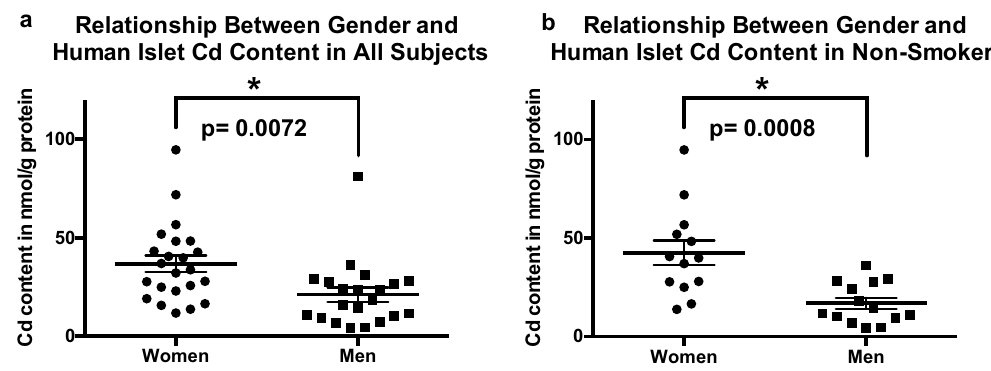
Figure 3. Relationship between gender and islet Cd content in all islet donors ( a ), and non-smokers ( b ). Analysis was performed using a two-tailed Student’s t-test. Center lines depict mean ± SEM, * denotes p <